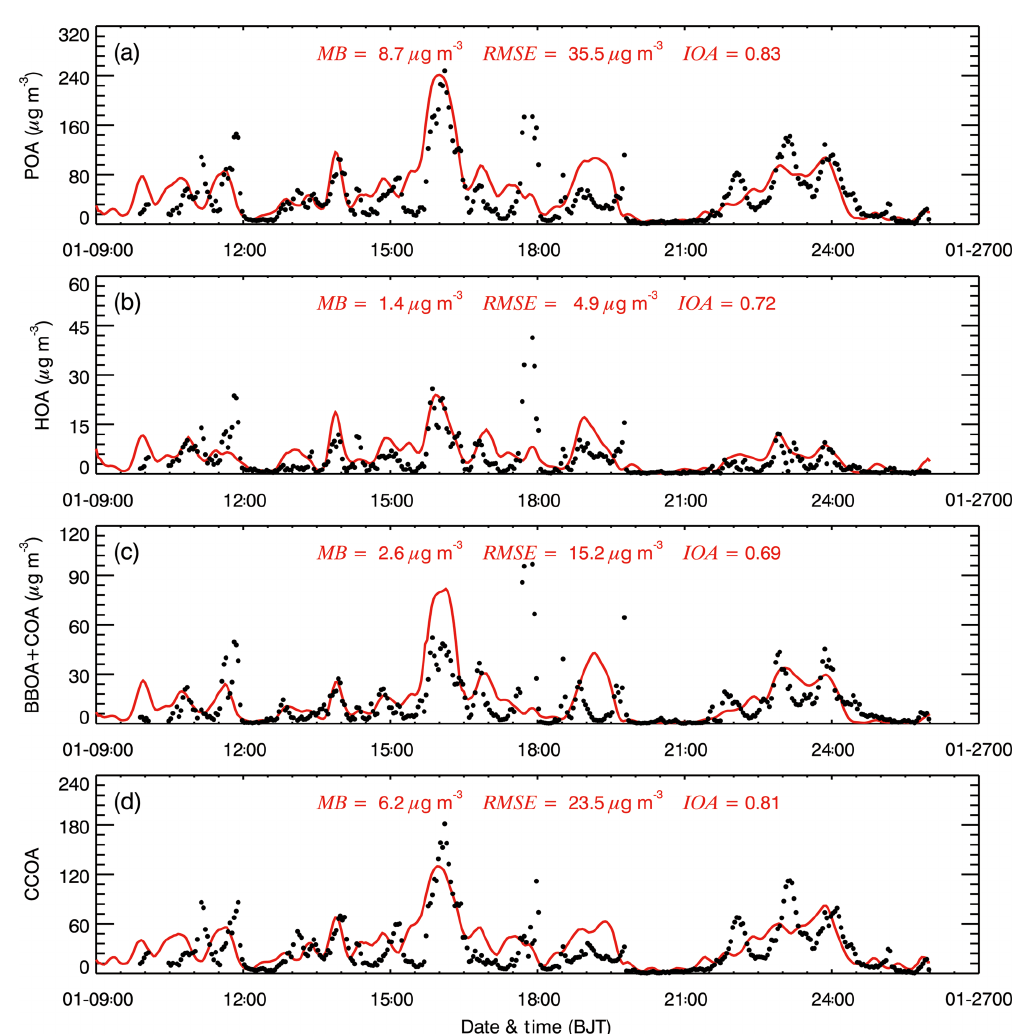
Figure 2. Comparisons of observed (black dots) and simulated (solid red lines) diurnal profiles of near-surface hourly mass concentrations of (a) POA, (b) HOA, (c) BBOA + COA, and (d) CCOA at the IRSDE site in Beijing from 9 to 26 January